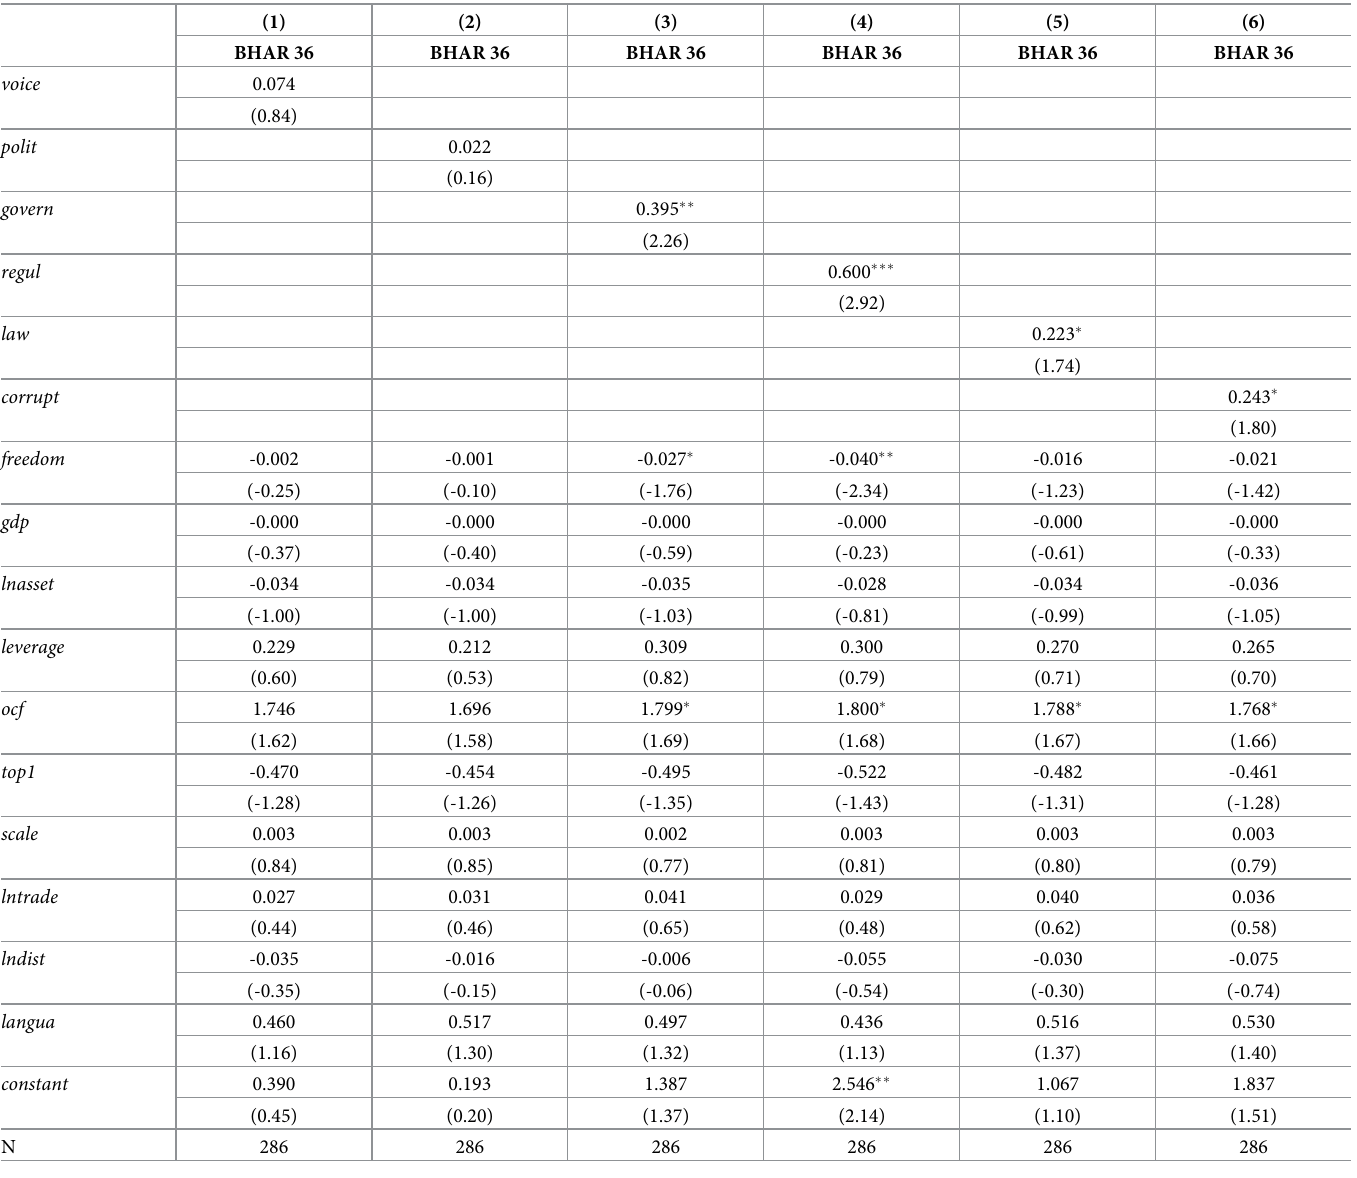
Table 4. Six dimensions of governmental governance capacity and